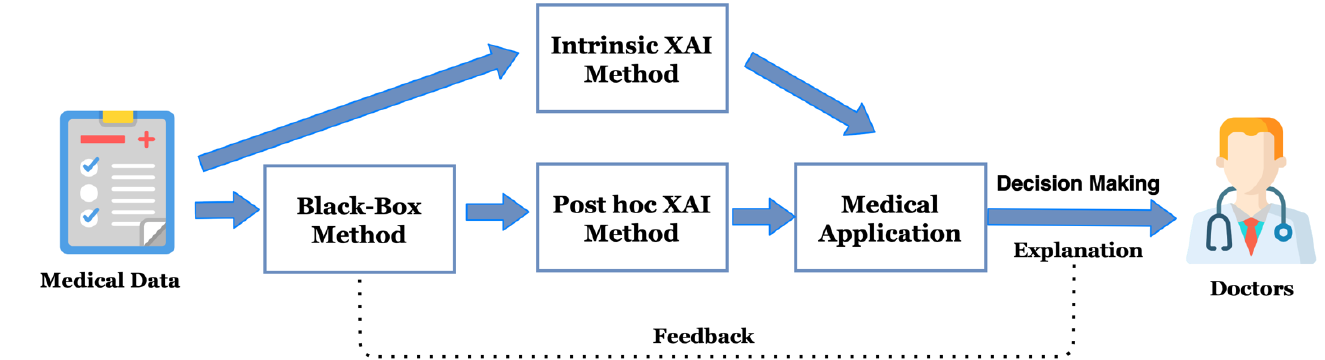
Figure 3. The overall pipeline of a medical XAI application: the XAI methods can be intrinsic or post hoc, and they can provide decision-making and explanation to the doctors.